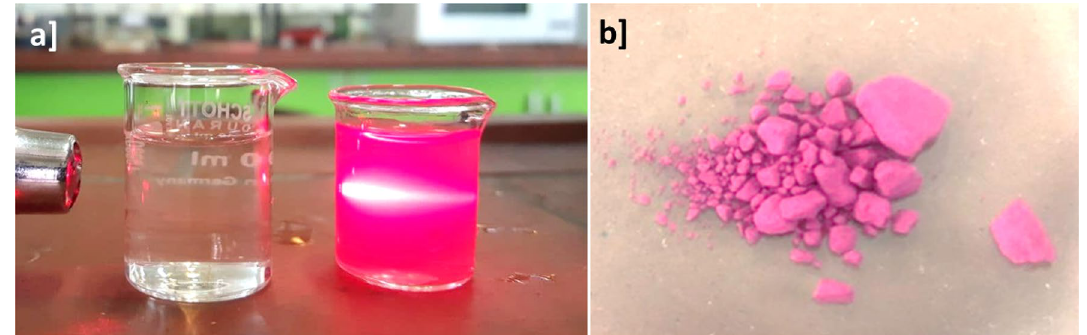
Figure 10. Light scattering experiment of colloidal ZnTPP/Cu-NPs ( a ) and prepared ZnTPP ( b